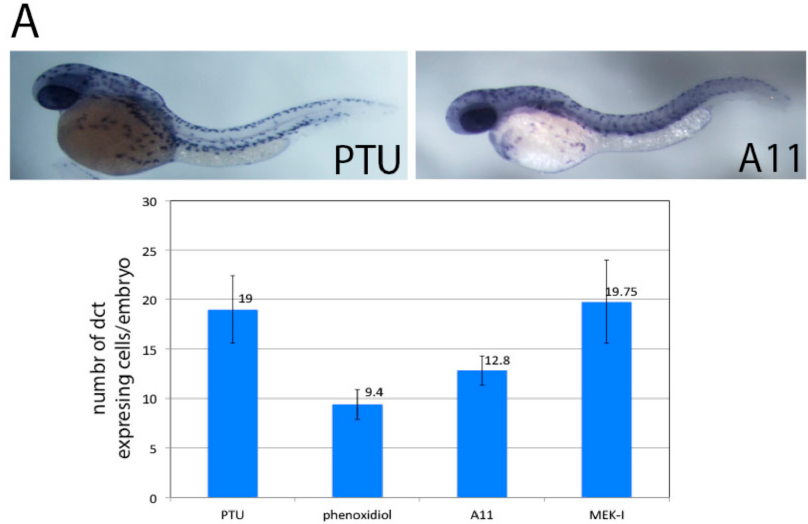
Figure 6. In vitro tyrosinase assay. Reaction containing L-tyrosine and tyrosinase with or without skin-lightening compounds were set up in triplicate in a 96-well plate. The absorbance at 475 nm were taken at 20 ′ , 60 ′ and 120 ′ . Several known skin-lightening compounds ( 8 – 11 ) showed strong tyrosinase inhibition, as the absorbance stayed near zero, including arbutin, kojic acid (KA), PTU, and niacinamide (Nia). However, A11 ( 5 ) and MEK-I ( 4 ) did not show any inhibition of tyrosinase at all as the tyrosinase functioned like in H 2 O ( 6